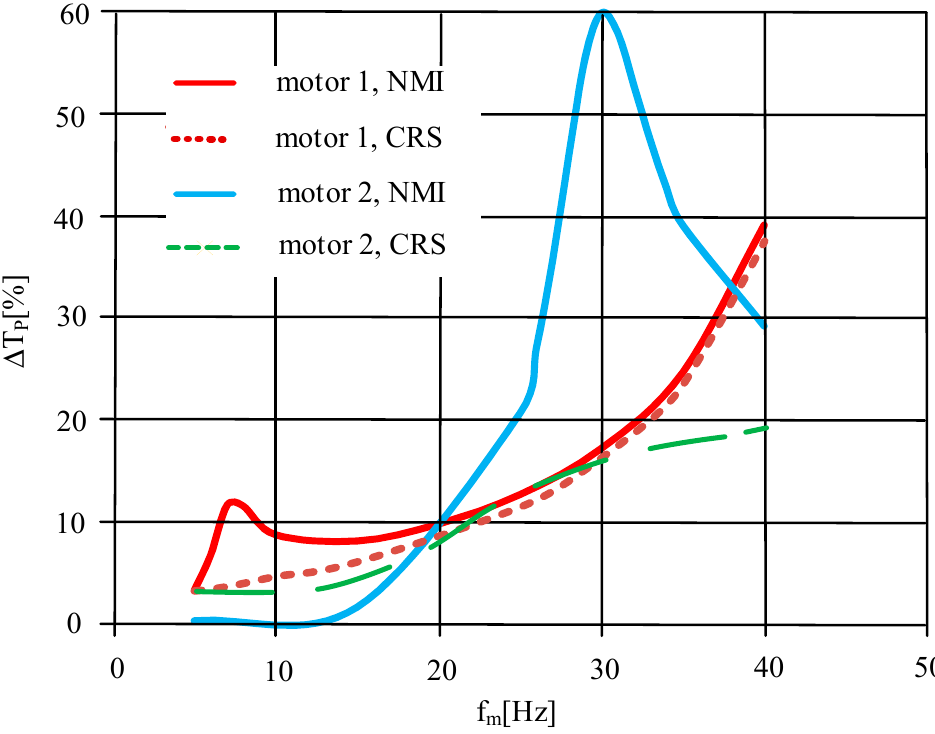
Figure 17. Pulsating torque component Δ T p of the frequency described with (21), (22) versus the frequency of the voltage modulation for the amplitude modulation ( ϕ sh = 0°, ϕ ih = 0°).